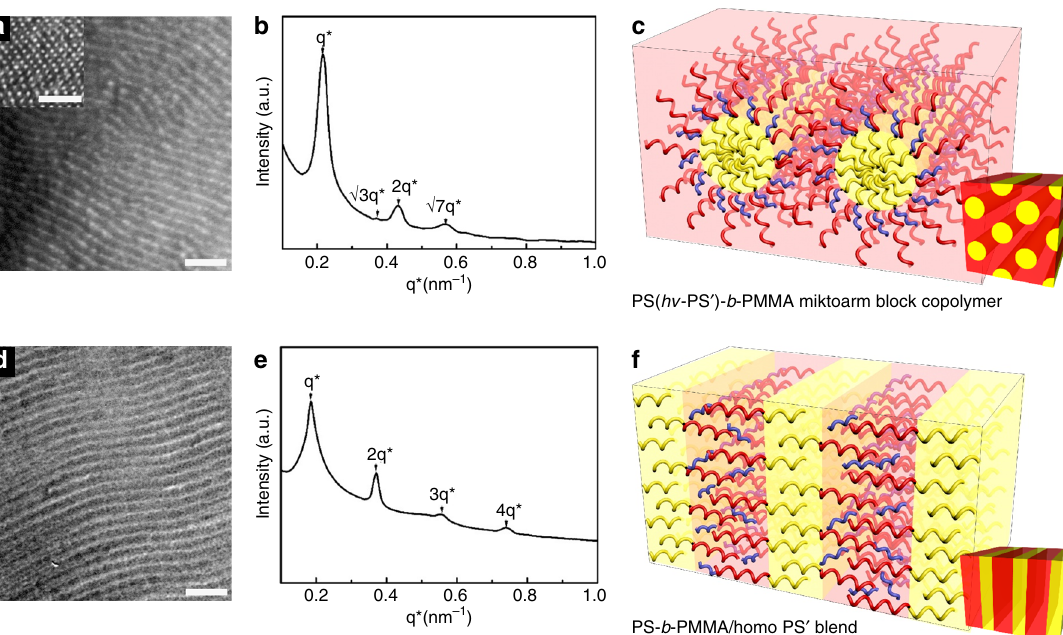
Fig. 2 Bulk morphologies before and after UV irradiation. TEM images of PS( hv -PS ′ )- b -PMMA a before and d after UV irradiation. Scale bar is 100 nm. SAXS pro fi les b before and e after UV irradiation for 2 h. Schematic of phase transition from cylinders to lamellae c before and f after UV